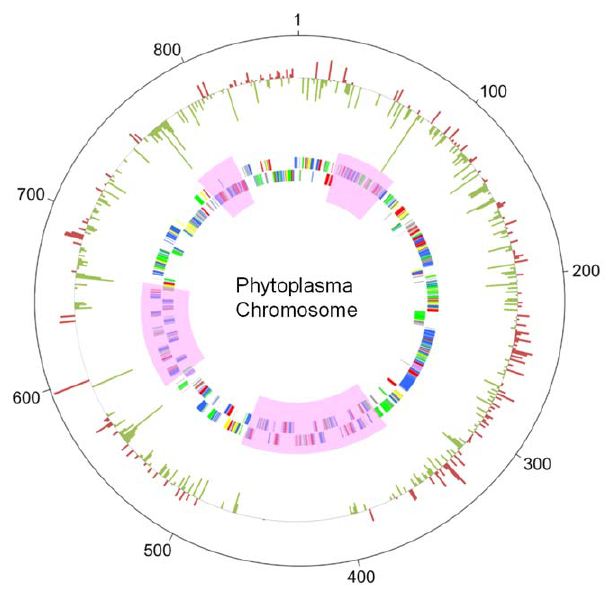
Figure 4. Circular representation of the OY-M phytoplasma chromosome and the ratio of expression level of each gene between in plant and in insect hosts. The outer circle shows the log2 ratio of expression level of each gene (expression level of OY-M grown in the plant host/expression level of OY-M grown in the insect host). Red bar shows high expression gene when grown in insect compared to when grown in plant. Green bar shows high expression gene when grown in plant compared to when grown in insect. The second circle shows predicted protein-coding regions on the plus strand. The third circle shows predicted protein-coding regions on the minus strand. Phage-like elements (called PMUs) are shown in pink.